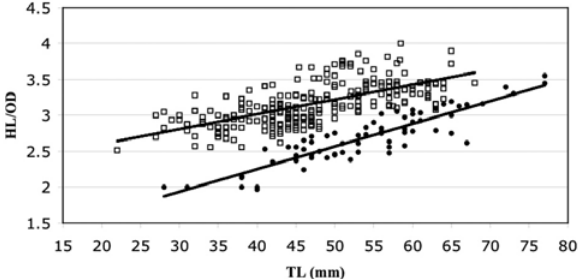
F IG . 4. – Plotted relationship between Total Length (TL, mm) and Head Length (HL, mm) / Orbital Diameter (OD, mm) for all